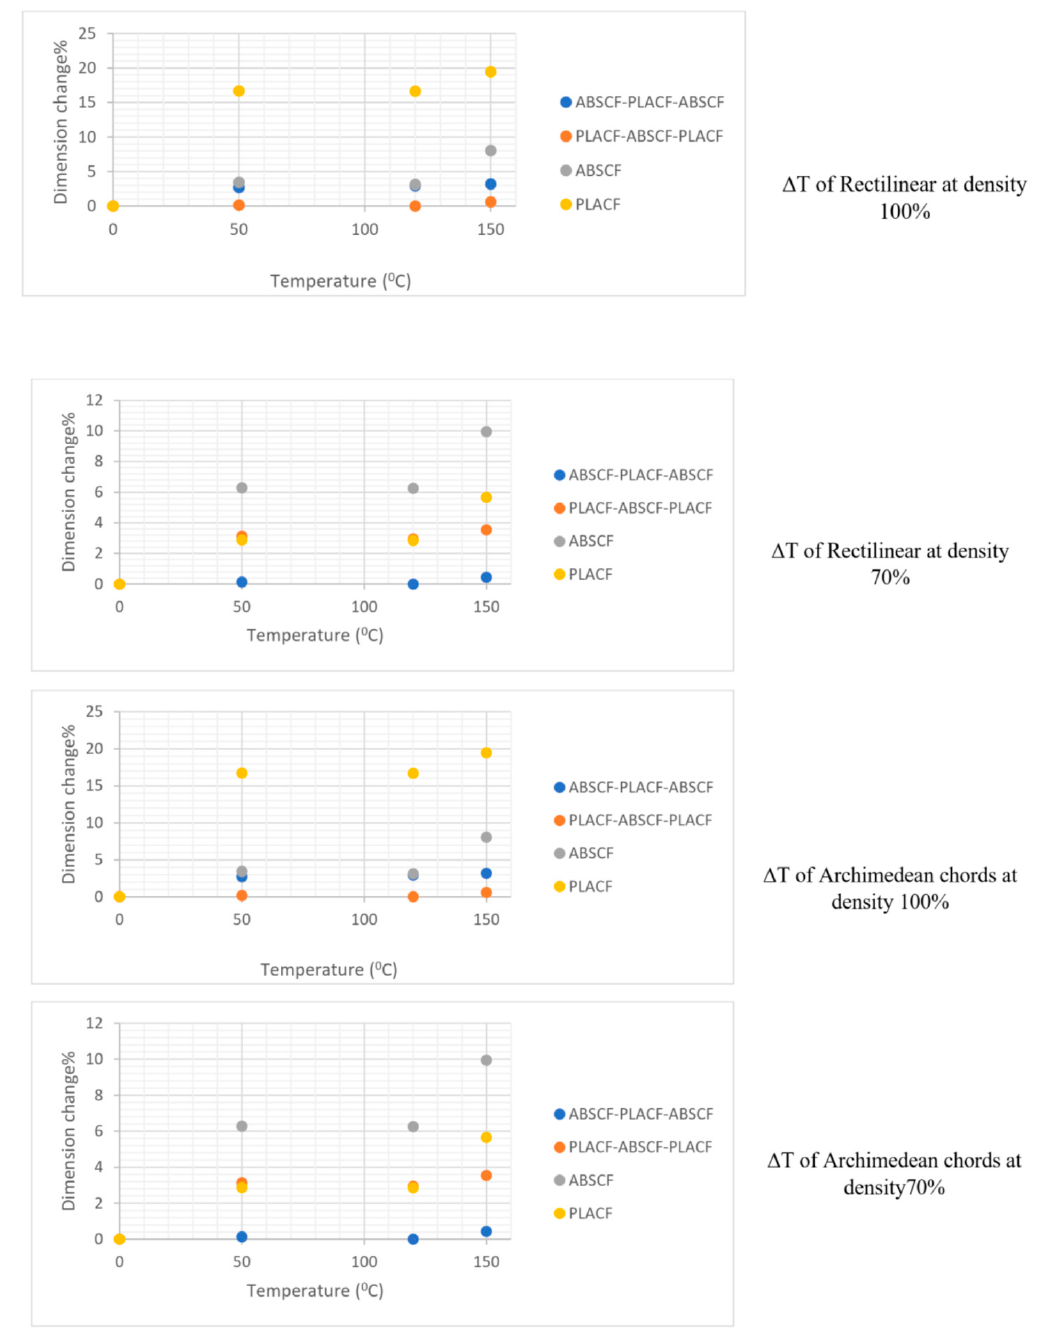
Figure 5. Relative change values of thickness (T) for the samples under different heat-treatment conditions.